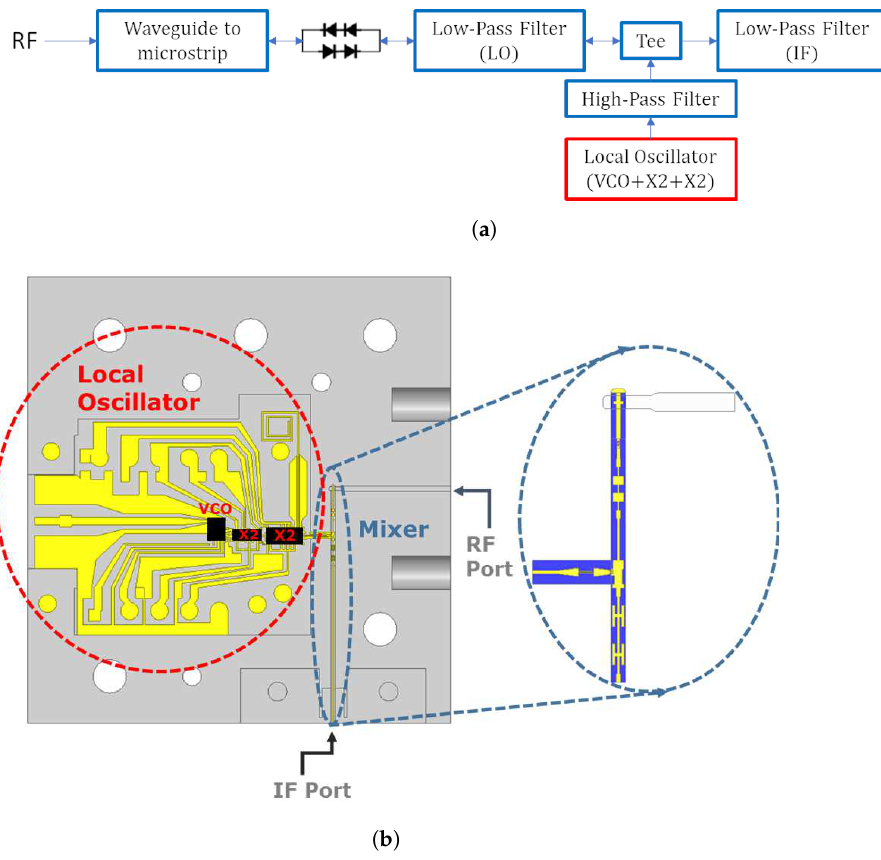
Figure 1. Configuration of the whole fourth-harmonic mixer with integrated MMIC local oscillator. ( a ) Schematic of the fourth-harmonic mixer circuit. ( b ) Top view of the design